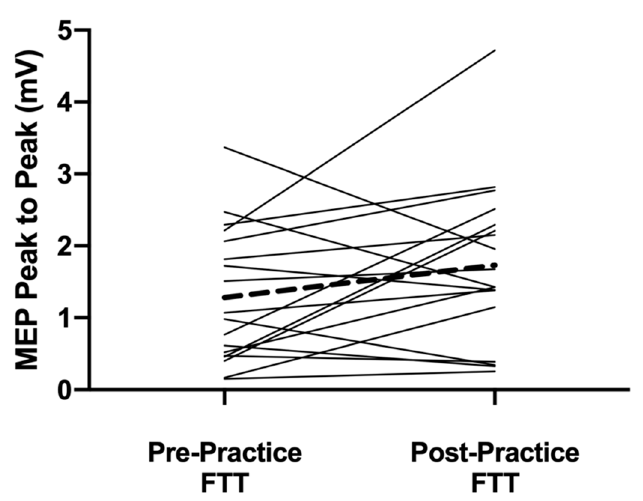
Figure 4. Motor-evoked potential size at an intensity 120% of resting motor threshold before and after the practice FTT for each individual subject. The dashed line denotes the mean change for the group. There was a significant increase in MEP size after practice ( p = 0.04) .